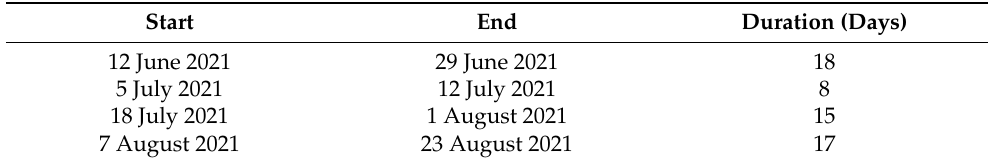
Table 1. 2021 heatwaves in the study